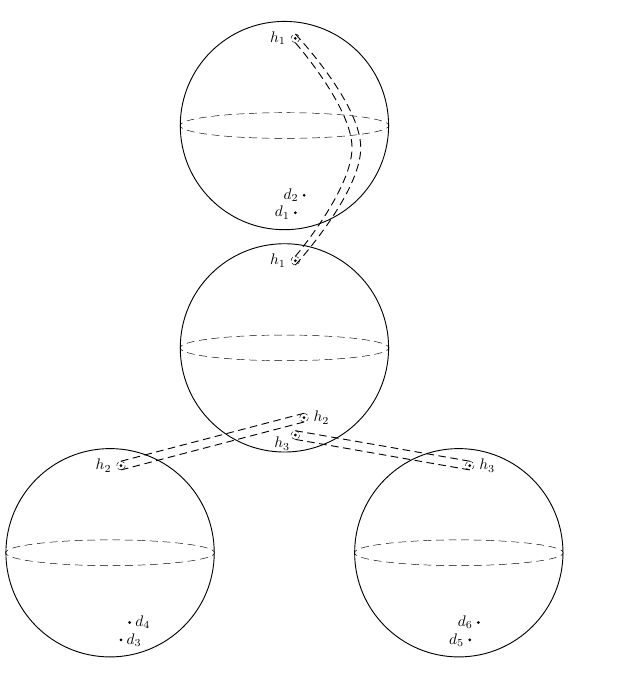
Figure 5. Plumbing construction for sphere 6-point conformal block in the trifundamental